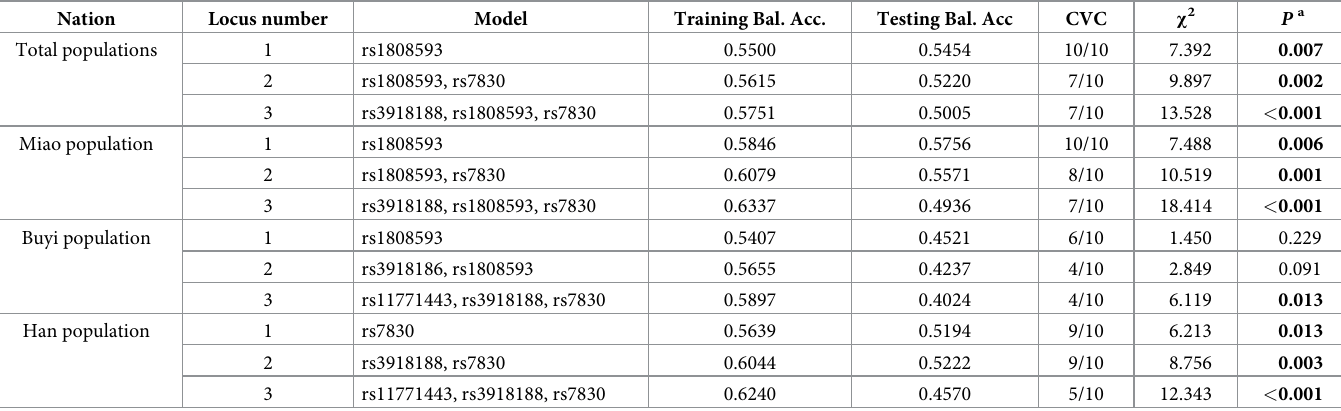
Table 6. MDR analysis for SNP-SNP interaction in NOS3 with EH risk. Nation